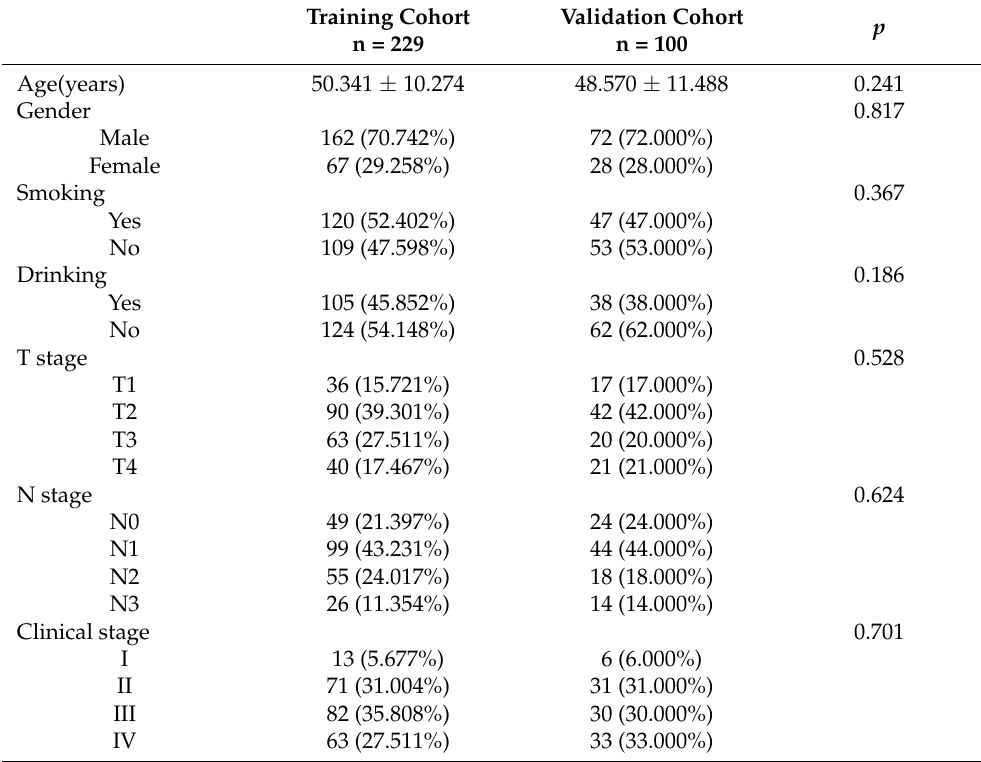
Table 1. Clinical characteristics of the training cohort and validation